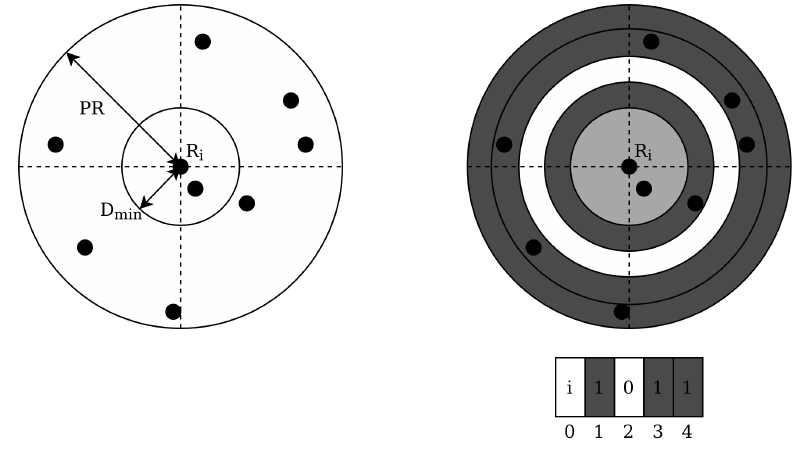
Figure 8. Feature extraction polestar